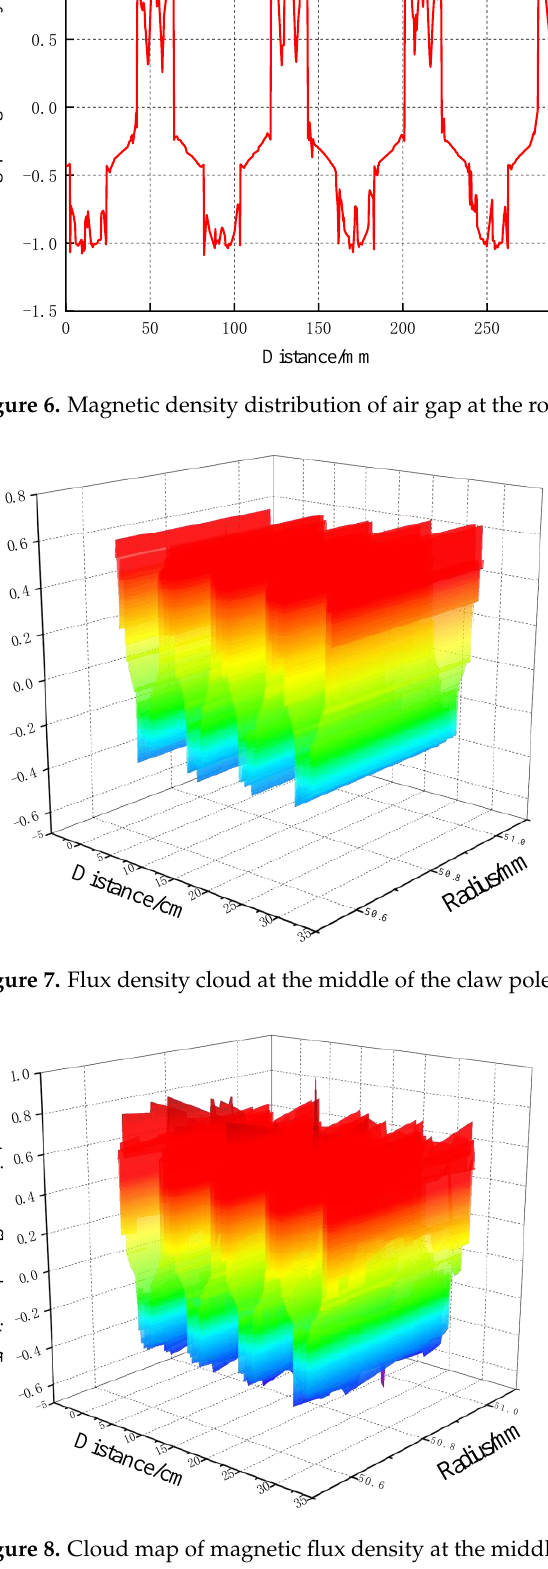
Figure 8. Cloud map of magnetic flux density at the middle of the air gap.